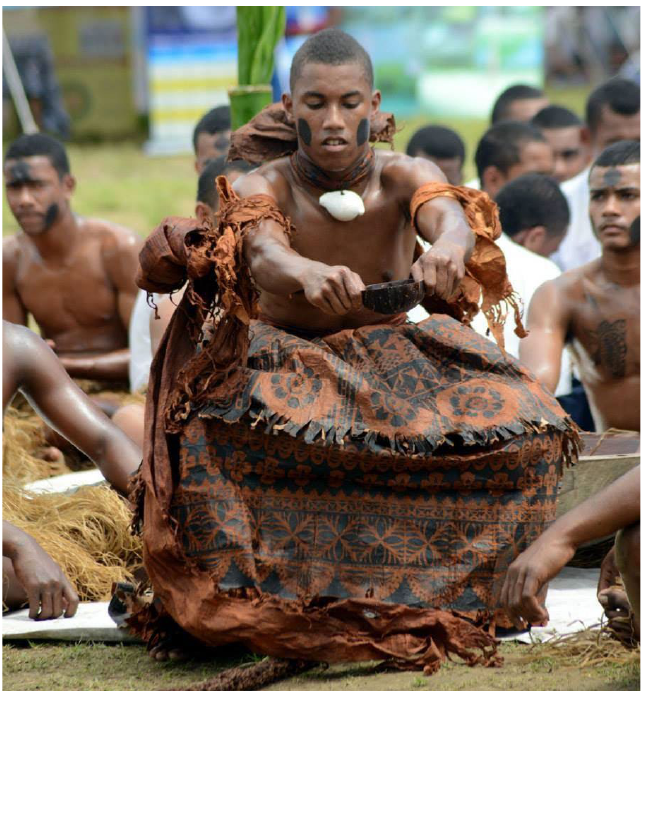
Figure 3: Ratu Viliami Katonivere (author’s cousin) and fellow Queen Victoria School students serve yaqona during Fiji Day Celebrations, Suva, 2013 (unknown